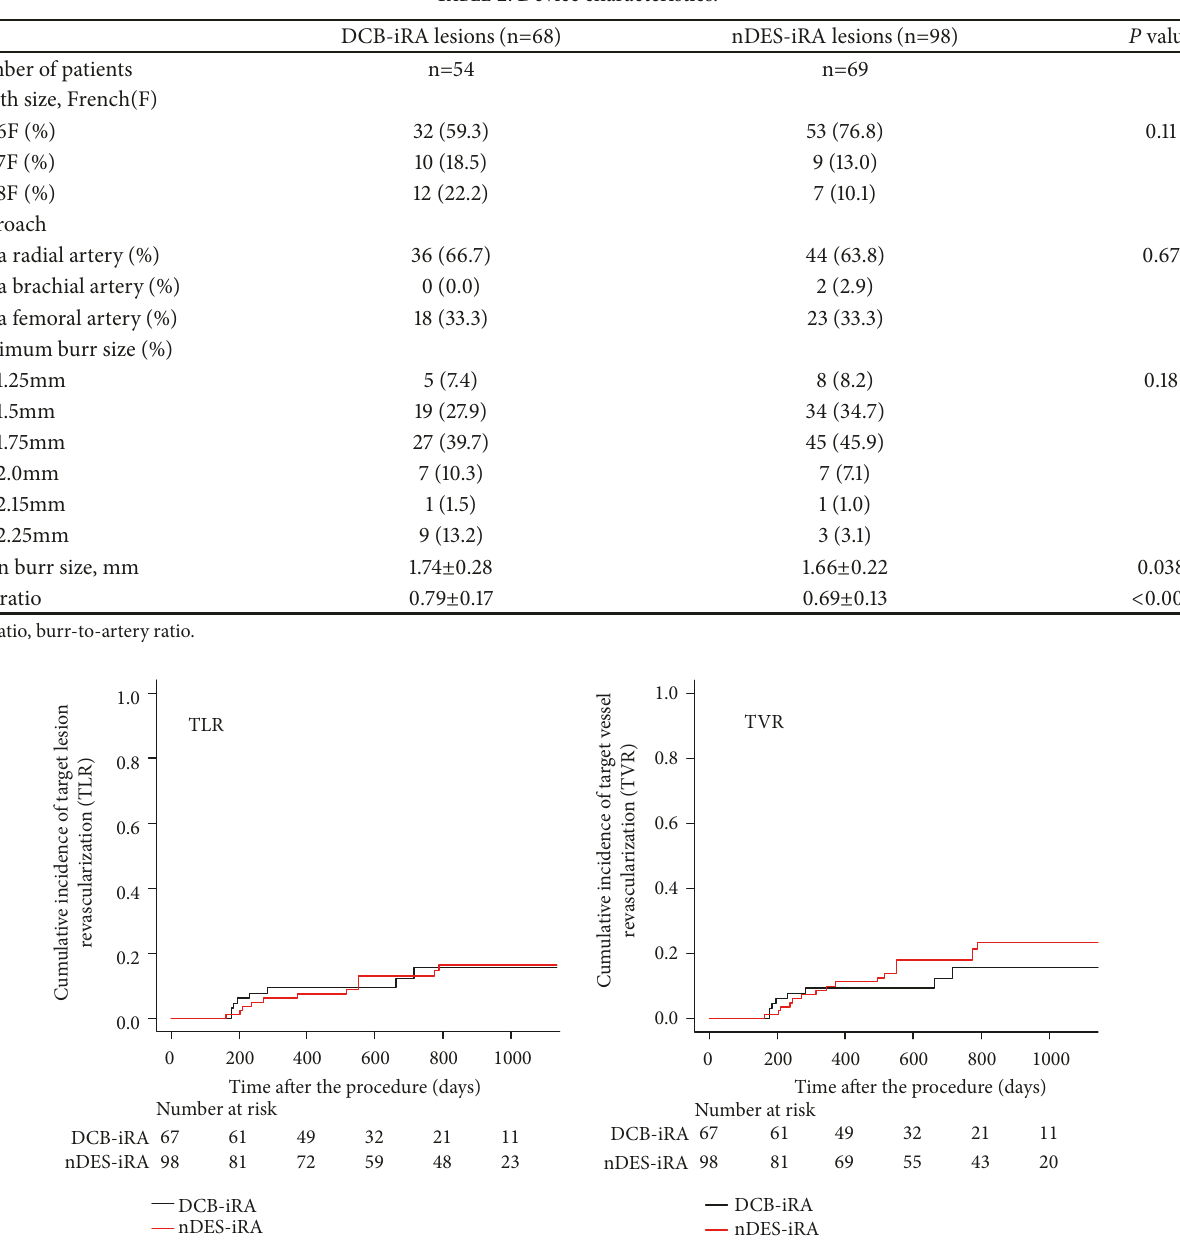
Table 2: Device characteristics.